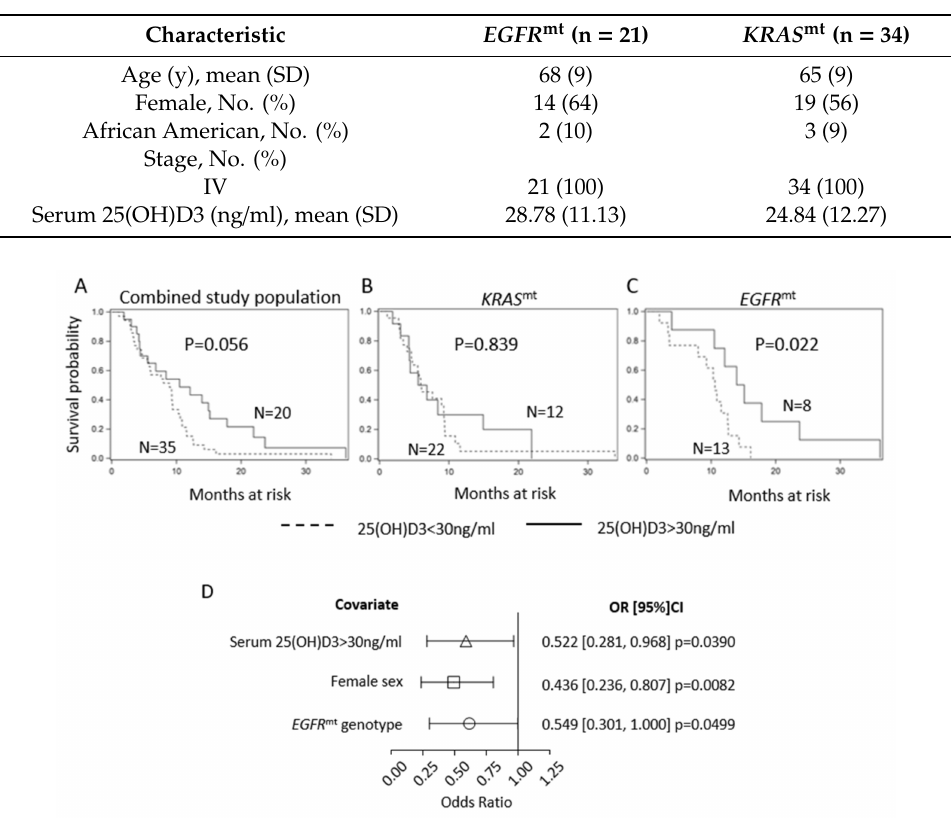
Table 1. Patients’ characteristics. Tumor stage and patients’ demographic characteristics were balanced across tumor genotypes.